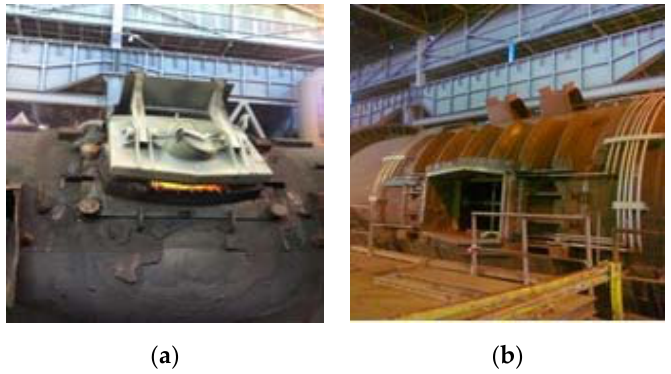
Figure 1. Layout of the furnace port. ( a ) Furnance in service; ( b ) maintenance shutdown. The plates of the port stand two different thermal loads. When the port cover is closed, the plates receive radiative flux from the burner flame, the melted copper and the remaining walls of the furnace, but with very low both surface area and view factor [5]. When the cover is opened, e.g., during the charging and pouring processes, a layer of slag or copper core at 1400 K flows over the plates. As a consequence, the pouring process imposes the highest thermal load to the bottom plates of the furnace port. Furthermore, a lack of information regarding the heat transfer from the slag flow to the plate was found,